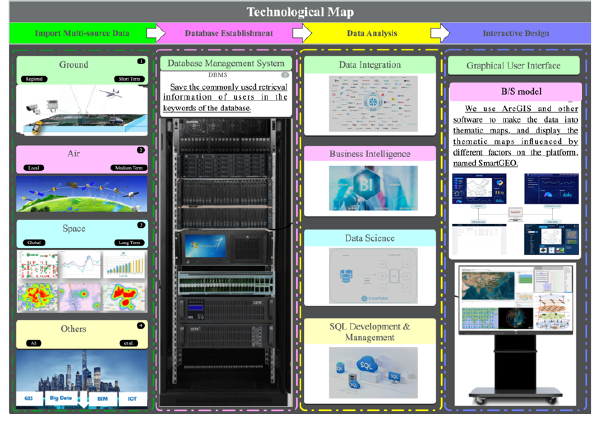
Figure 1 . Research and application of